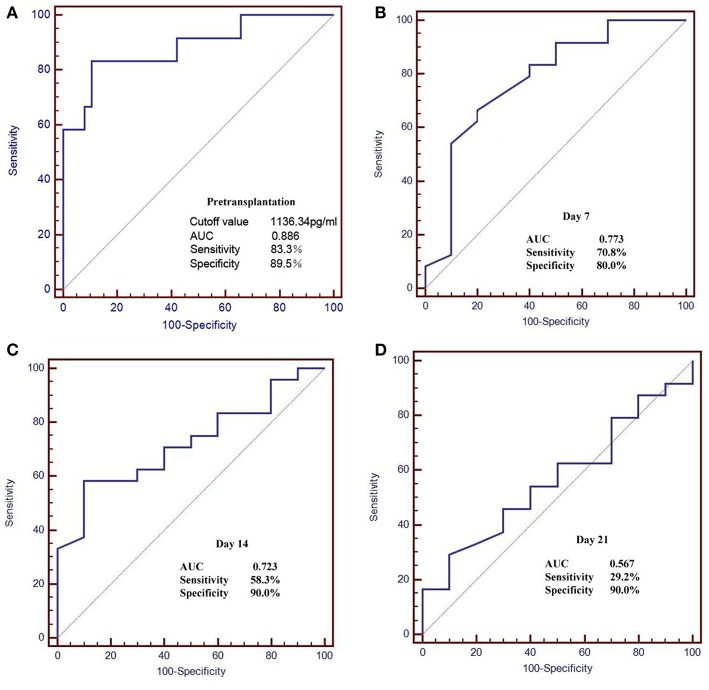
Receiver operating characteristic (ROC) curves for serum BAFF level in the prediction of AR. (A) The pretransplant serum BAFF levels presented the best predictive value with the biggest areas under the curve (AUCs) (0.886), and showed a good sensitivity (83.3%) and specificity (89.5%). (B–D) The serum BAFF on day 7, 14, 21 post transplant presented lower sensitivity and specificity than the pretransplant serum BAFF.